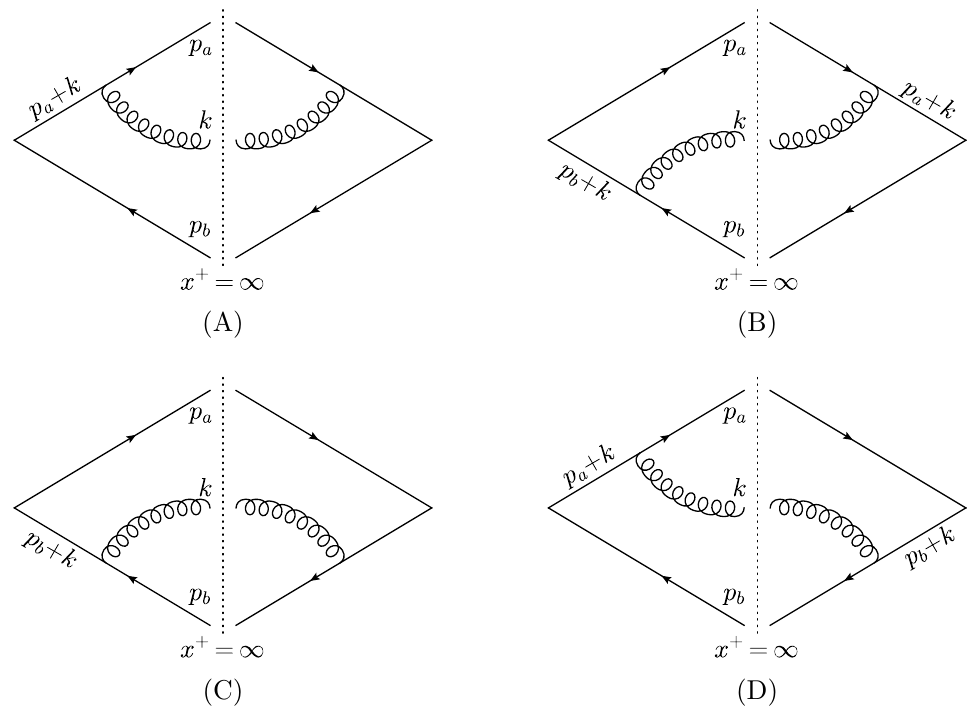
Figure 3 . The 4 graphs which contribute to the emission probability of a soft gluon by an antenna in